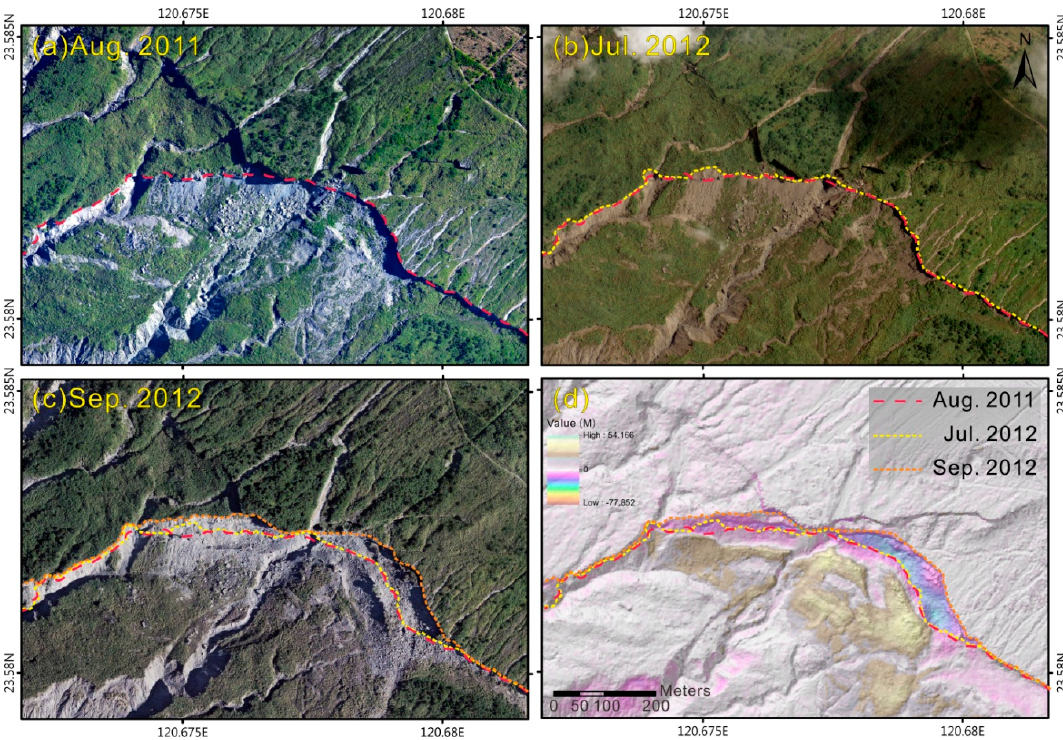
Figure 10. Movement of the slope line of the Chunqiu Cliff demonstrating the effects of erosion from August 2011 to September 2012: ( a ) the orthoimage taken in August 2011, where the red dashed line represents the position of the Chunqiu Cliff; ( b ) the orthoimage taken in July 2012, where the yellow dashed line represents the position of the Chunqiu Cliff; ( c ) the orthoimage taken in September 2012, where the orange dashed line represents the position of the Chunqiu Cliff; and ( d ) the DEM-based terrain shadow map illustrating elevation evolution during 2011–2012, superimposed with the slope position of the Chunqiu Cliff at the three time points shown in ( a – c ). It can be inferred that the terrain elevation change is mainly due to the torrential rain brought by Typhoon Soula on 30 July 2012.